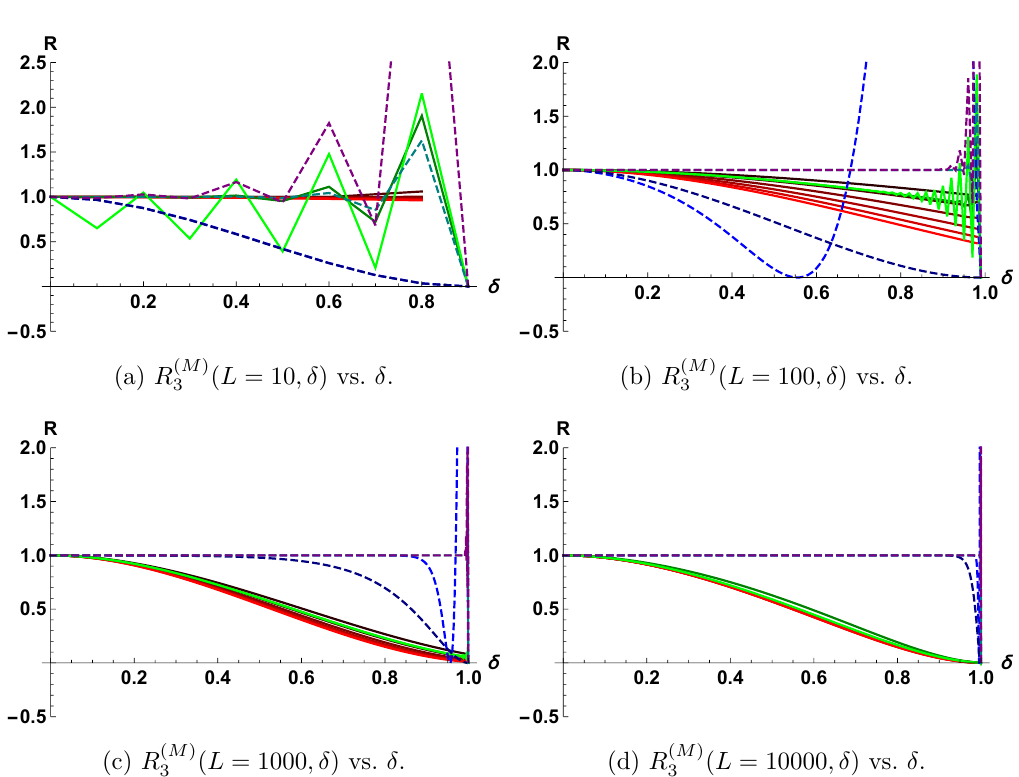
Figure 8. Mass multipole ratios without M 0 in the numerator: R ( M ) figure 6.